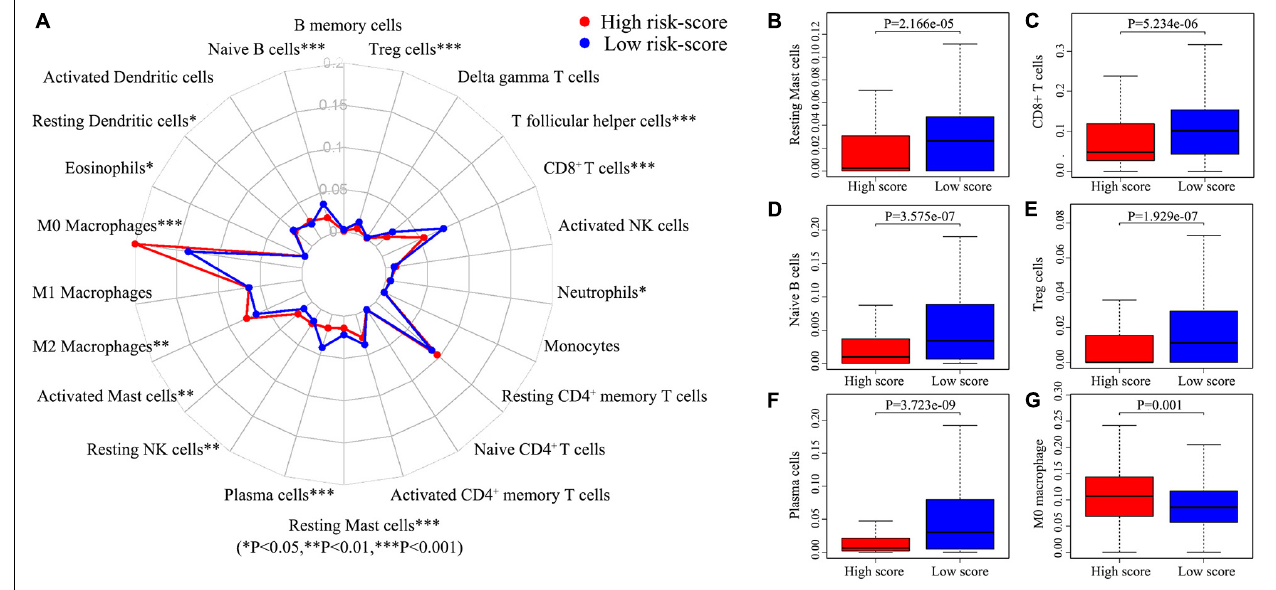
FIGURE 4 | Immune cells correlation of IRGPs signature in HNSCC. (A) Using CIBERSORT calculated the abundance of 22 different immune cells in high score group and low score group of HNSCC. The abundance distribution of (B) Resting mast cells, (C) CD8 + T cells, (D) Naïve B cells, (E) Treg cells, (F) Plasma cells, and (G) M2 macrophages within the two groups ( P < 0.05).